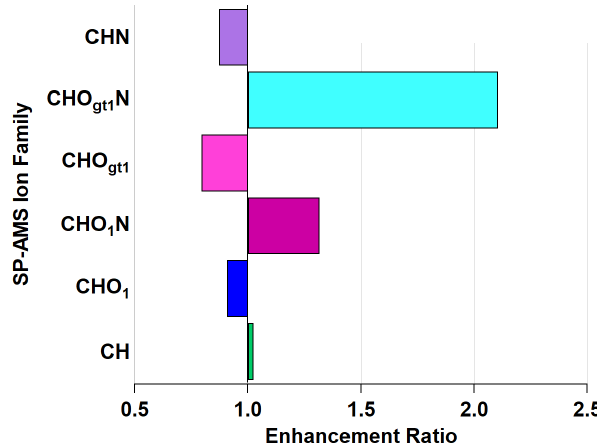
Figure 6. Enhancement and depletion of ion families measured by (cid:113) the AMS during NO 3 oxidation. CHO 1 N and CHO gt1 N, while present in lower relative abundances, showed the largest enhance- (cid:113) ment through NO 3